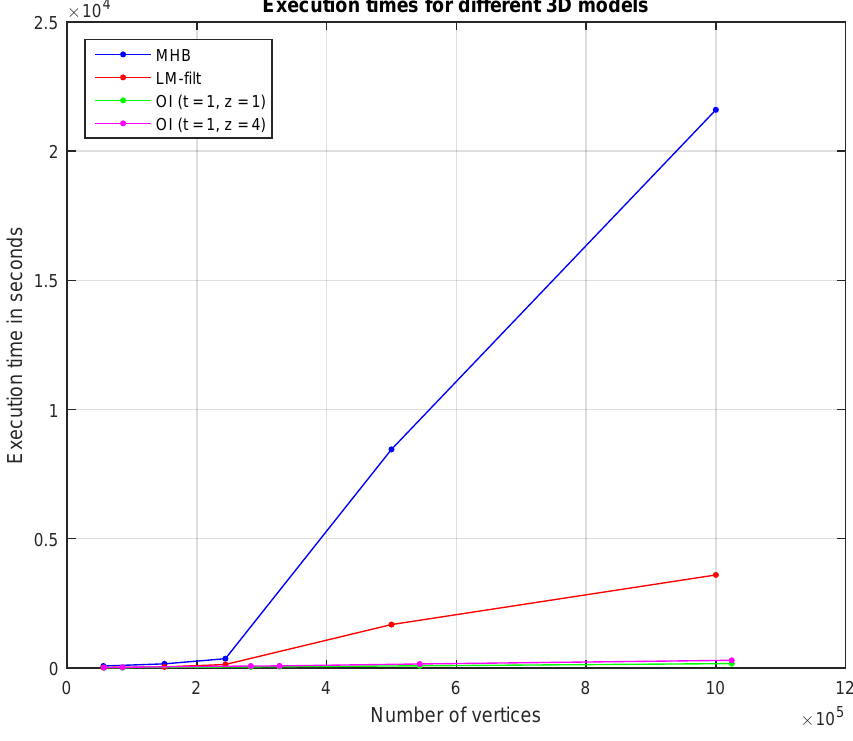
Figure 11. Execution times for different 3D